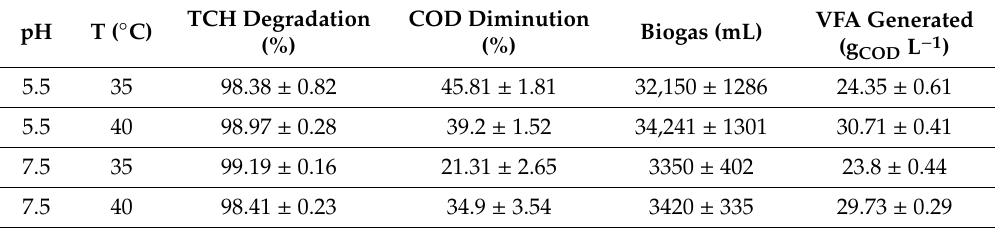
Table 2. Results of experimental test used to evaluate the pH and temperature e ff ects on the VFA production during anaerobic treatment of raw cheese whey.